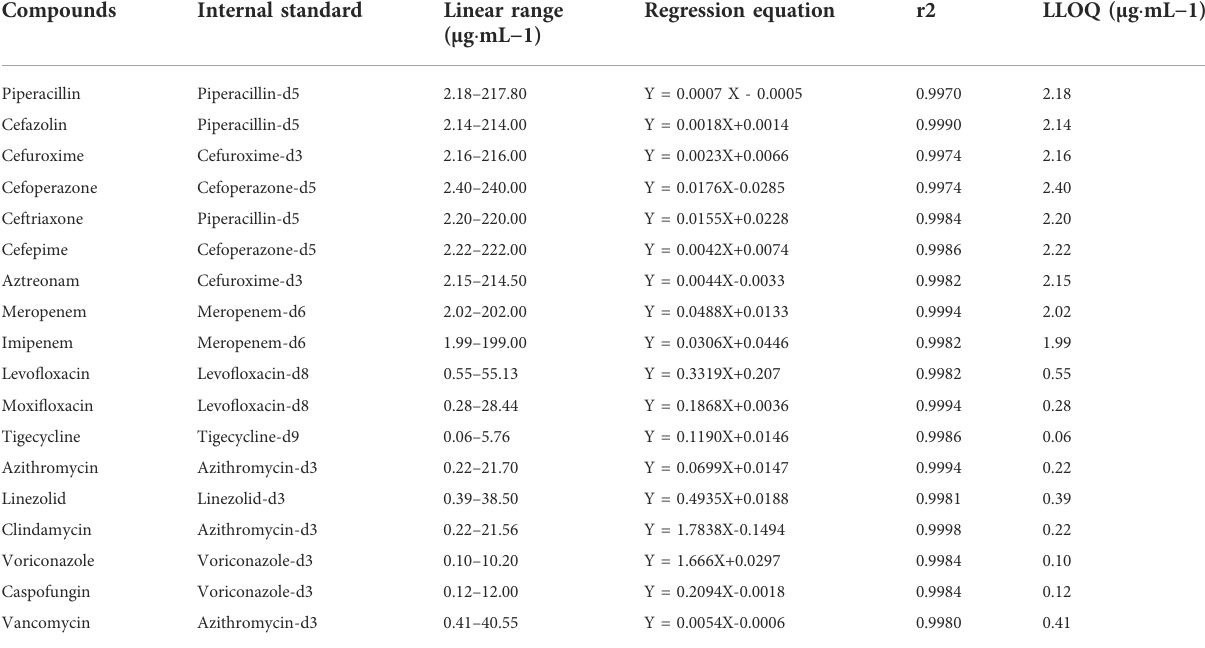
TABLE 3 Linear ranges, linear equations, correlation coef fi cients, and LLOQ of 18 antimicrobial agents.